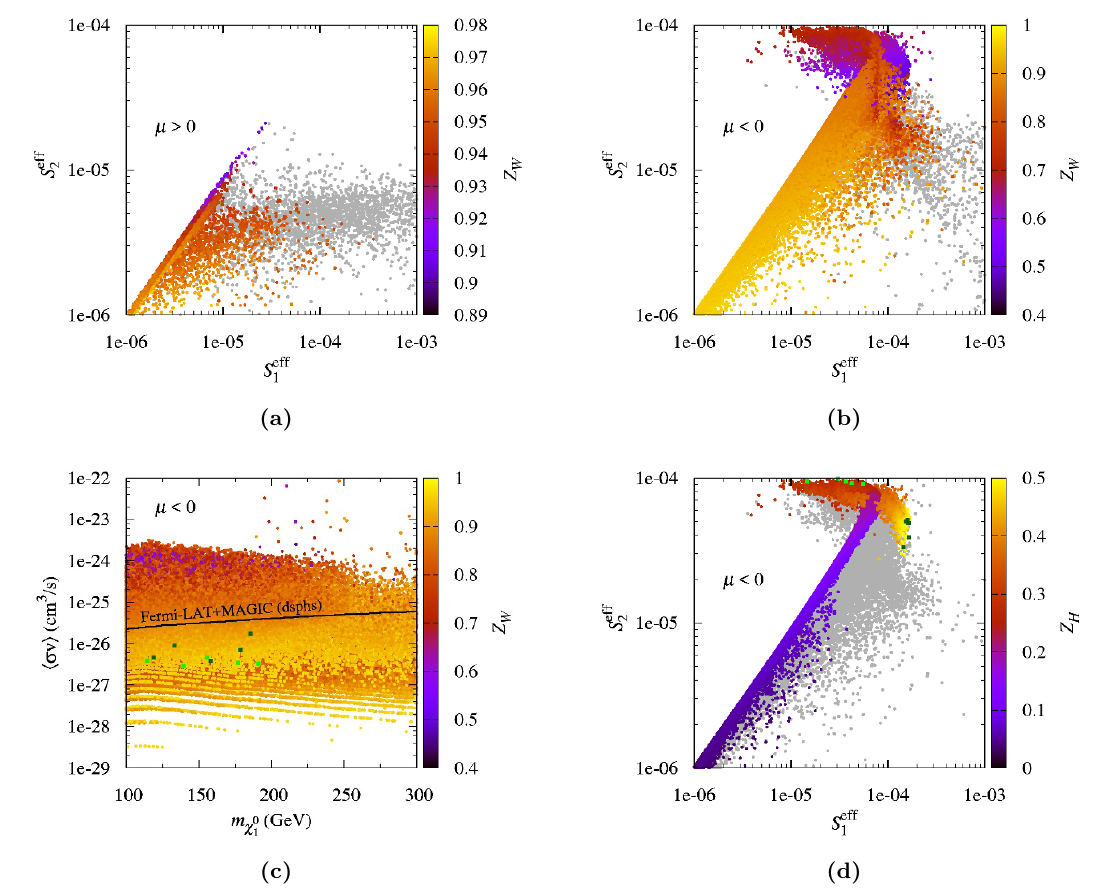
Figure 2. The two e(cid:11)ective cross sections, S e(cid:11) from the parameter space scans for (a) the (cid:22) > 0 case and (b, c, d) the (cid:22) < 0 case. The colour map in (a, b and c) corresponds to the wino component and in (d) to the higgsino component in The grey points in (a, b) are the ones ruled out by the XENON1T constraint, and are shown only for a perspective. The grey points in (d) are similarly the ones further ruled out by the combined 95% CL exclusion limits from Fermi-LAT and MAGIC collaborations, i.e, those lying above the corresponding line shown in